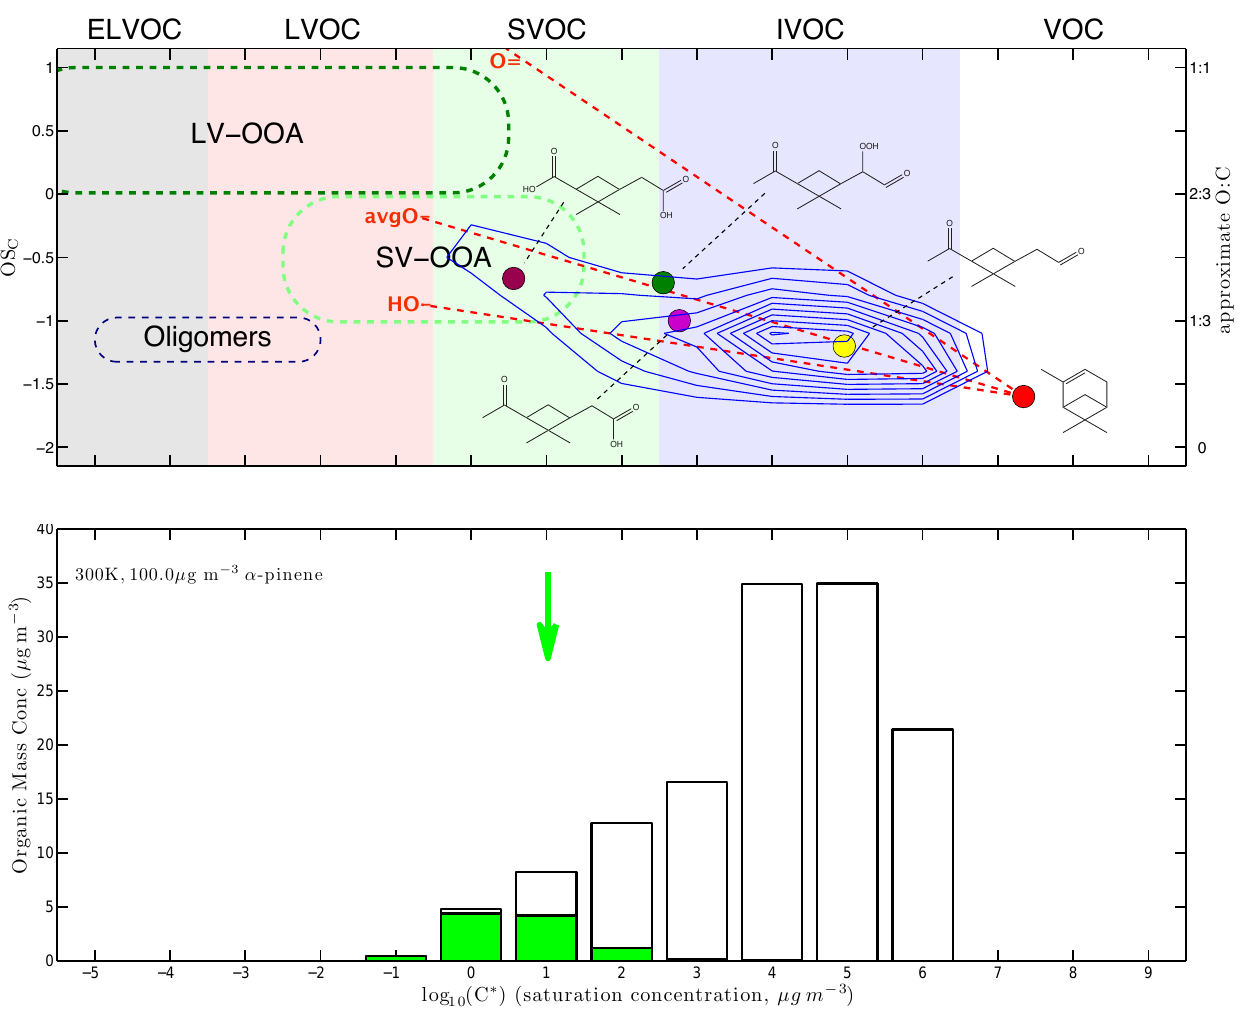
Fig. 3. Products from the ozone + α -pinene reaction in one and two dimensions. (a) The product mass distribution is shown with blue contours. Representative 1st generation products are indicated with colored circles within the contours, along with their molecular struc- tures. α -Pinene is shown with a red circle. The dashed red lines extending from the α -pinene point of origin indicate the trajectories for functionalization in this 2-D space. The middle line is near the value for organic acids and also the average value assumed for 2-D-VBS calculations. (b) A 1-D-VBS product distribution for the same SOA, given by vertical sums over OS C for each log 10 C ∗ bin. Partitioning is shown for ∼ 10 µg m − 3 of SOA, obtained from oxidation of 100 µg m − 3 of α -pinene, with condensed-phase OA in green and vapor-phase products in